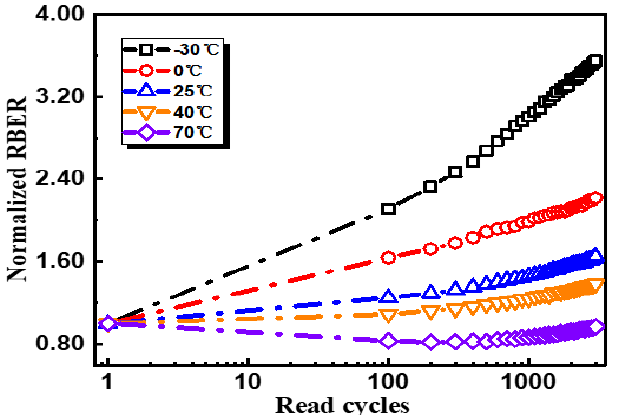
Figure 5. Read disturb characterizations at different temperatures from − 30 to 70 °C.